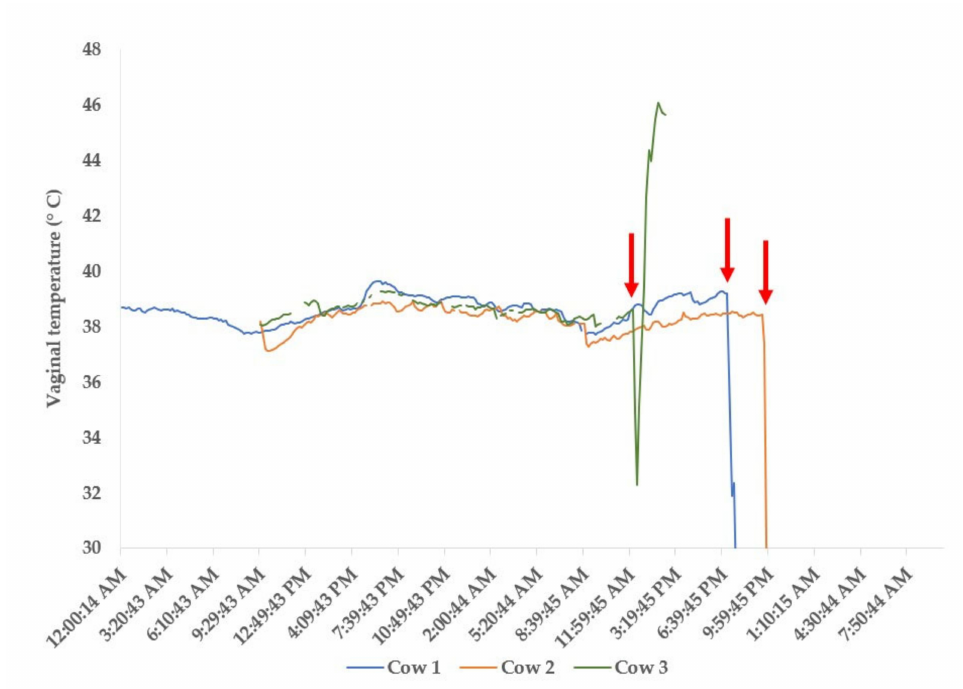
Figure 4. Vaginal implant tag temperature of three cows in the lead up to calving. Arrows indicate the VIT expulsion